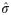
Parameter statistics of all 1,283 researchers in the database grouped by discipline.We show the maximum likelihood fitted model parameters (top and center) and the fraction of secondary publications (bottom). The black horizontal dashed line indicates the median of all researchers. For clarity, we do not show the values of σ^ for 9 researchers that are outliers.